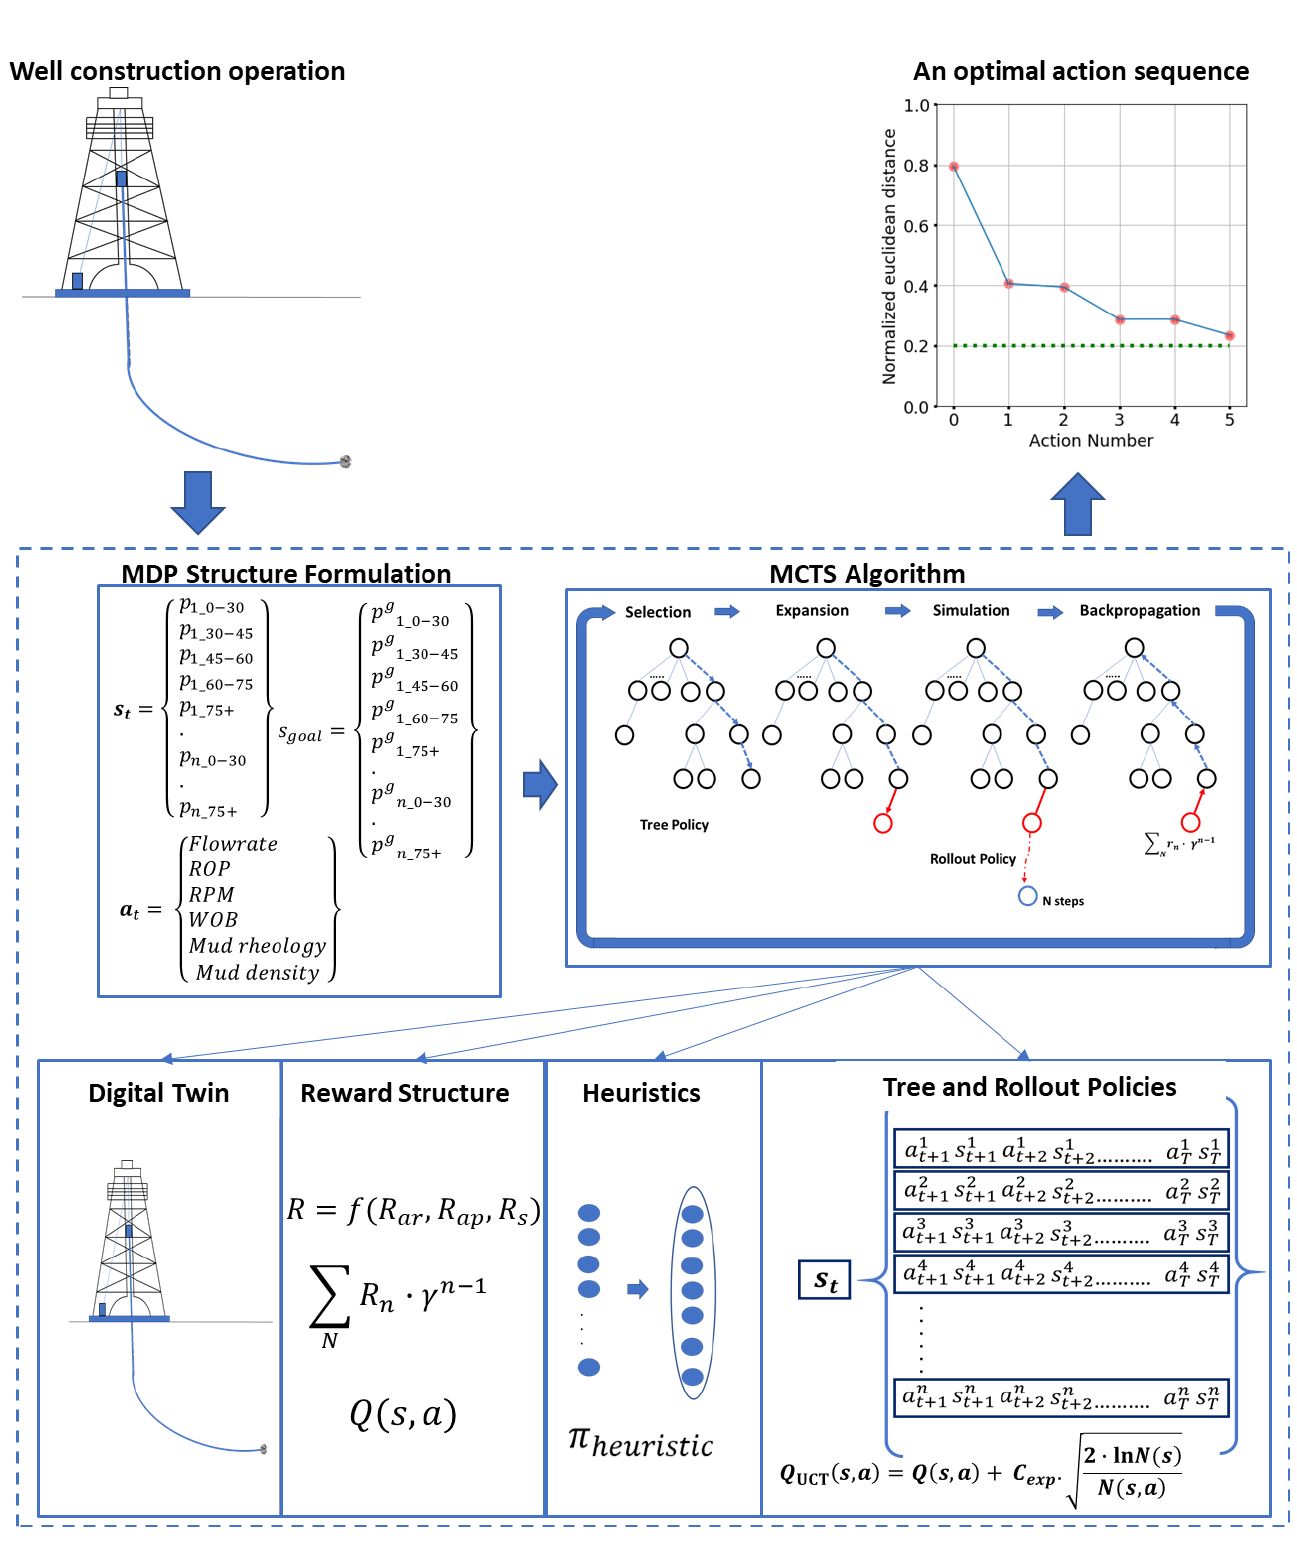
Figure 4. Structure of the proposed decision-engine. Upper right figure shows progression of the normalized Euclidean distance of the system states (blue line) to an acceptable goal state (shown by the green dotted line, here taken to be a state at a normalized Euclidean distance of 0.2).